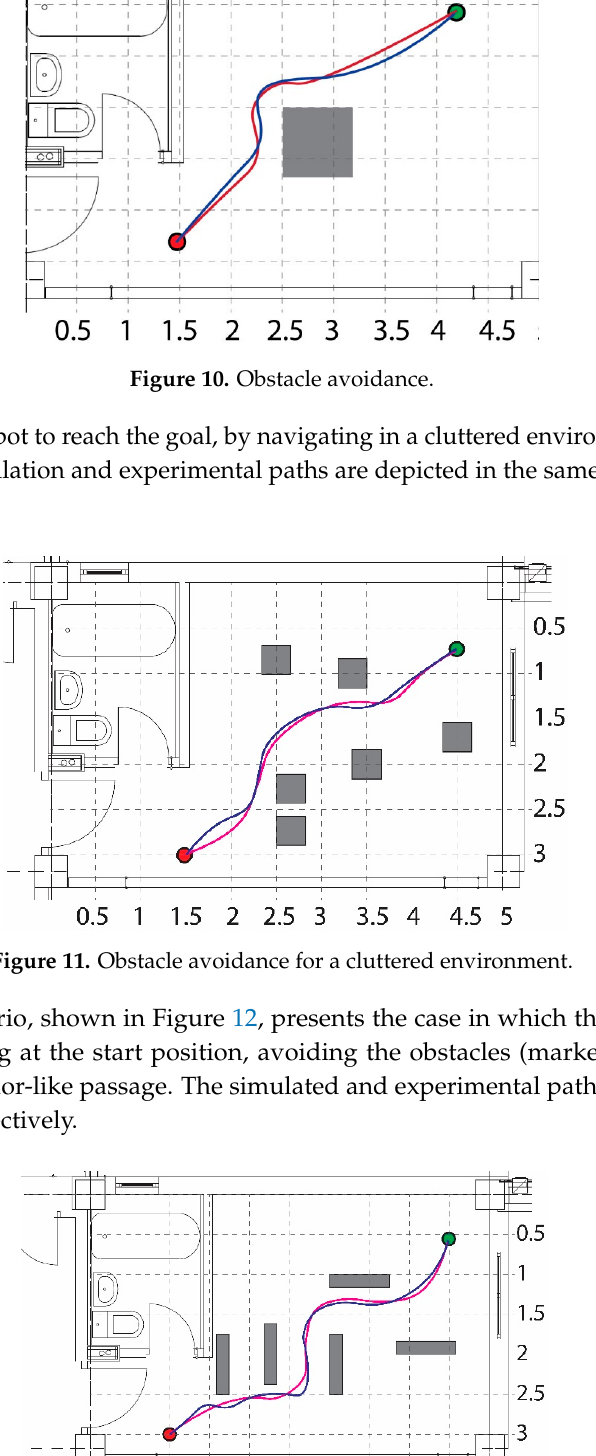
Figure 12. Obstacle avoidance in a corridor-like environment.